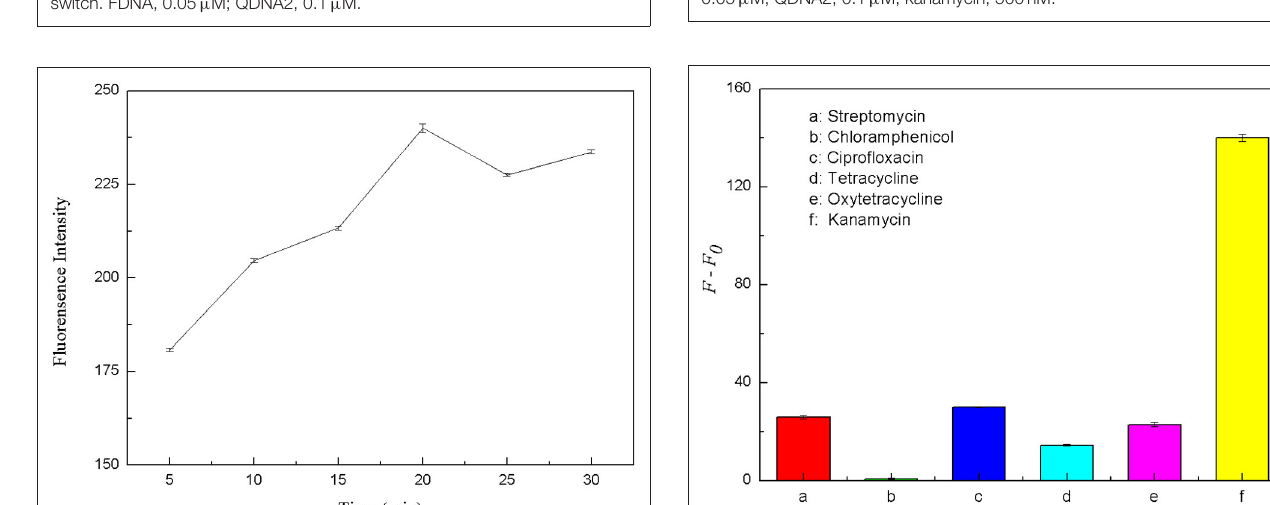
FIGURE 6 | Optimization of formation time for the double-helix of structure switch. FDNA, 0.05 µ M; QDNA2, 0.1 µ M.